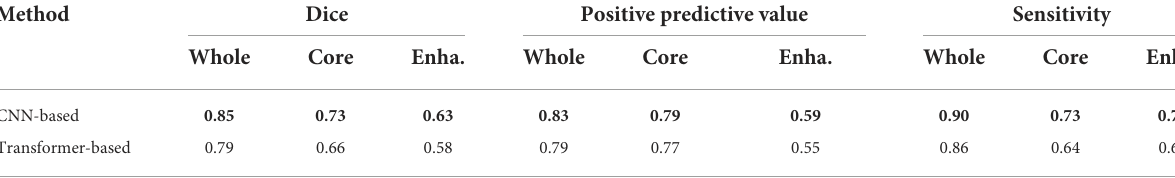
TABLE 4 Results of different discriminators training from